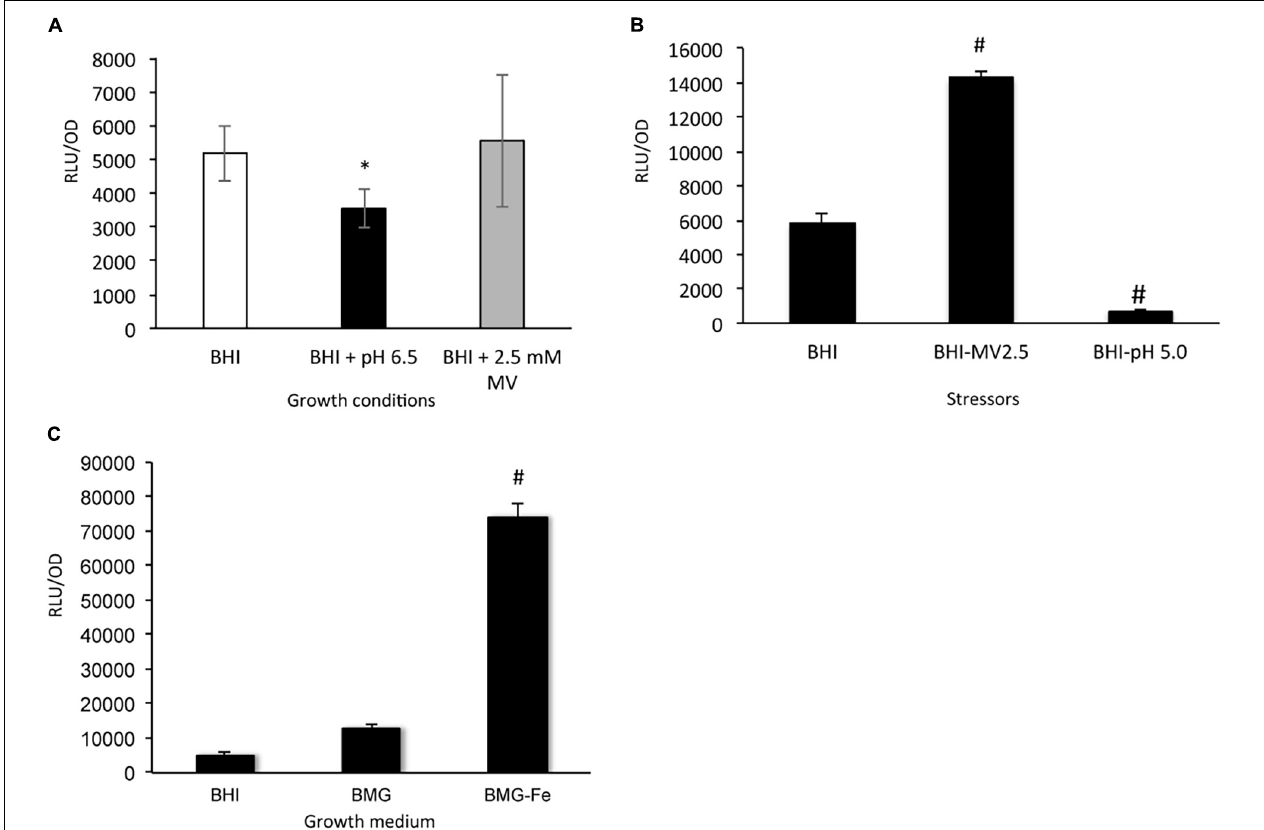
FIGURE 9 | SufCDSUB expression by reporter fusion assays. (A) Luciferase reporter activity in Streptococcus mutans wild-type, UA159 at mid-exponential phase (OD 0.4) was evaluated when grown in BHI with pH adjusted to 6.5 (black) and BHI with the inclusion of methyl viologen (2.5 mM, final conc., gray) simulating acid and oxidative stressors, respectively and compared to regular BHI (white). (B) When the reporter strain, UA159 carrying the luciferase reporter, was first grown in regular BHI and then transferred to BHI with methyl viologen at 2.5 mM or BHI adjusted to pH 5.0 and incubated for one hour, methyl viologen was shown to increase reporter activity, while pH 5.0 reduced the reporter activity. #, P < 0.01 vs BHI control. (C) To test the effects of iron-limitation on suf expression, the reporter strain was evaluated in regular BHI (BHI) and BMG (BMG) and BMG without ferric chloride (BMG-Fe). Results showed that transfer from Fe